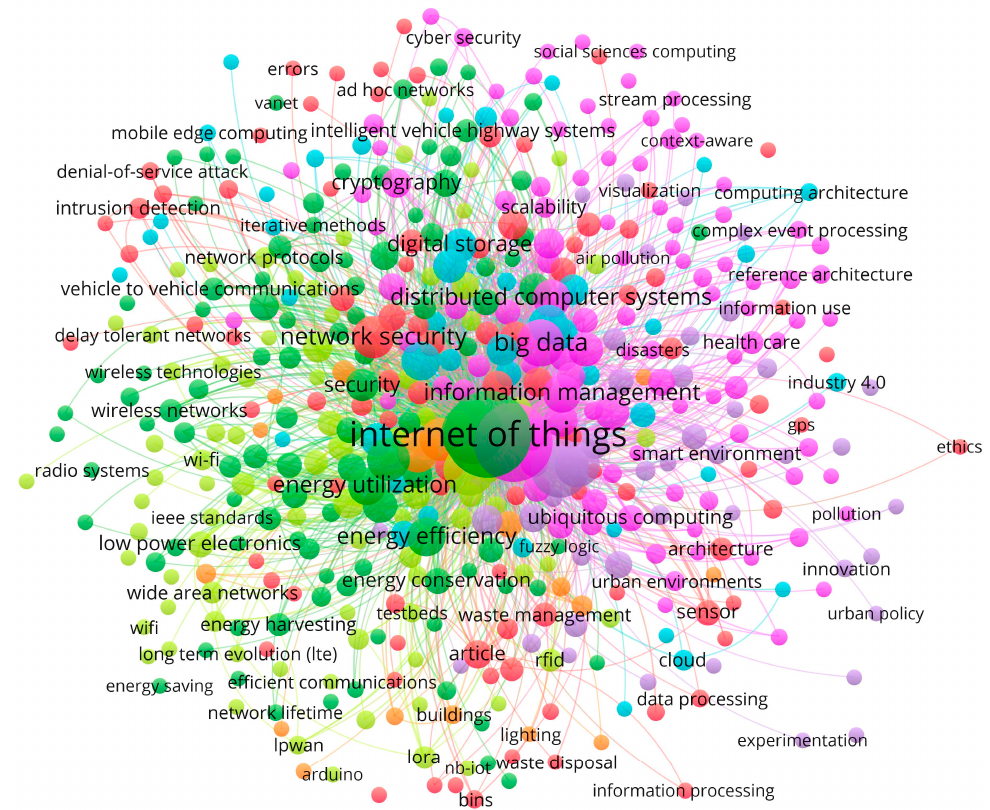
Figure 4. Keywords network based on the co-occurrence method (2011–2019).